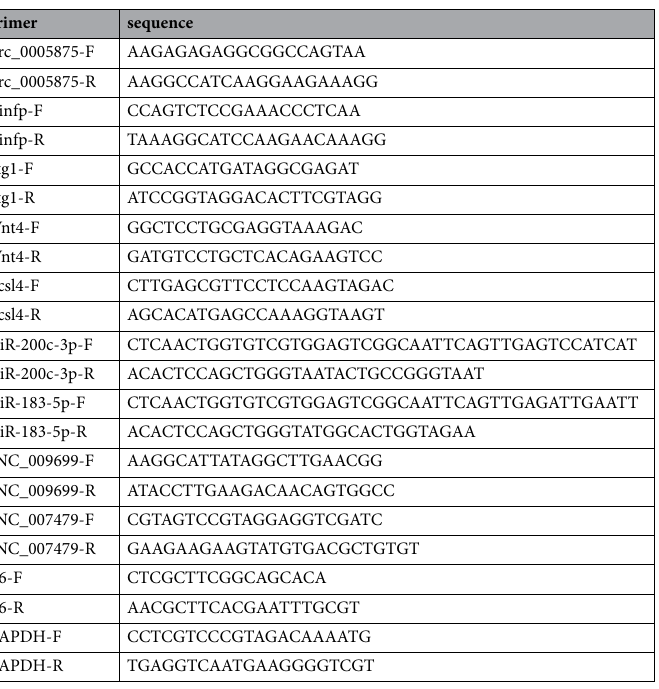
Table 1. Primer sequences used in the experiment. The forward and reverse primer of circ_0005875, Hinfp, Btg1, Wnt4, Acsl4, miR-200c-3p, miR-183-5p, LNC_009699, LNC_007479 were